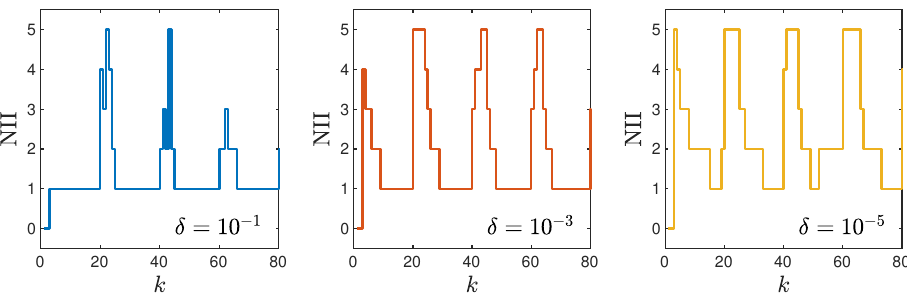
Figure 6. Simulation results: the number of internal iterations (NII) in the consecutive sampling instants of the MPC-NPLPT-L 1 algorithm for three values of the parameter δ